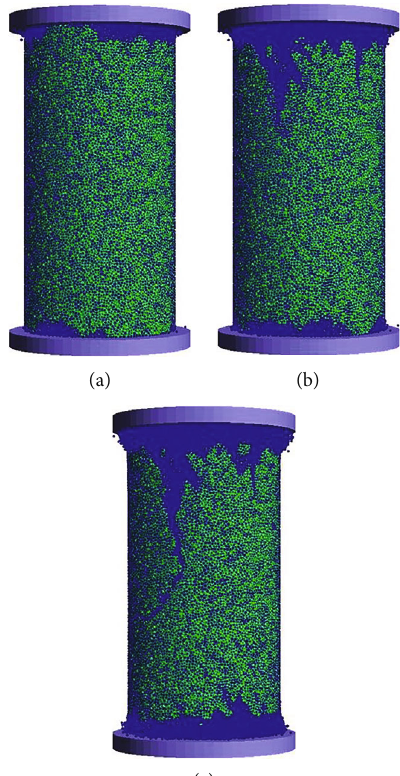
Figure 8: Schematic diagram of model splitting failure process under uniaxial compression.